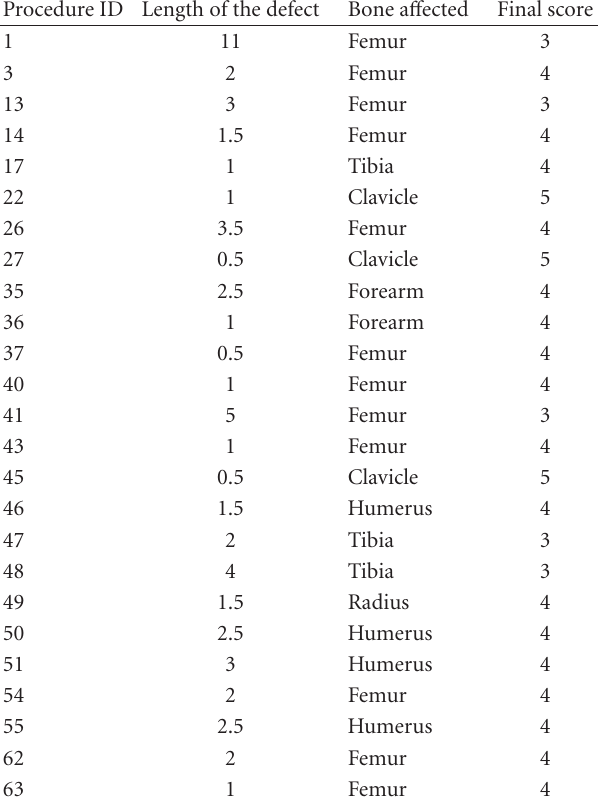
Figure 6: A tibial bone defect reconstructed with BCP. X-Ray image of a tibial fracture (a) with the lateral (b) and anterior view (c) after 2 years of reconstruction using the BCP. Table 4: Lengths of the segmental bone defects. Nineteen proce- dures were performed in defects smaller than 3cm in length and six, in defects equal or larger than 3cm. The final scores (combination of clinical and radiographic analysis) are described. One patient received bilateral intervention. The majority of good and excellent results (scores 4 and 5) were observed in patients with defects equal or smaller than 3cm in length.